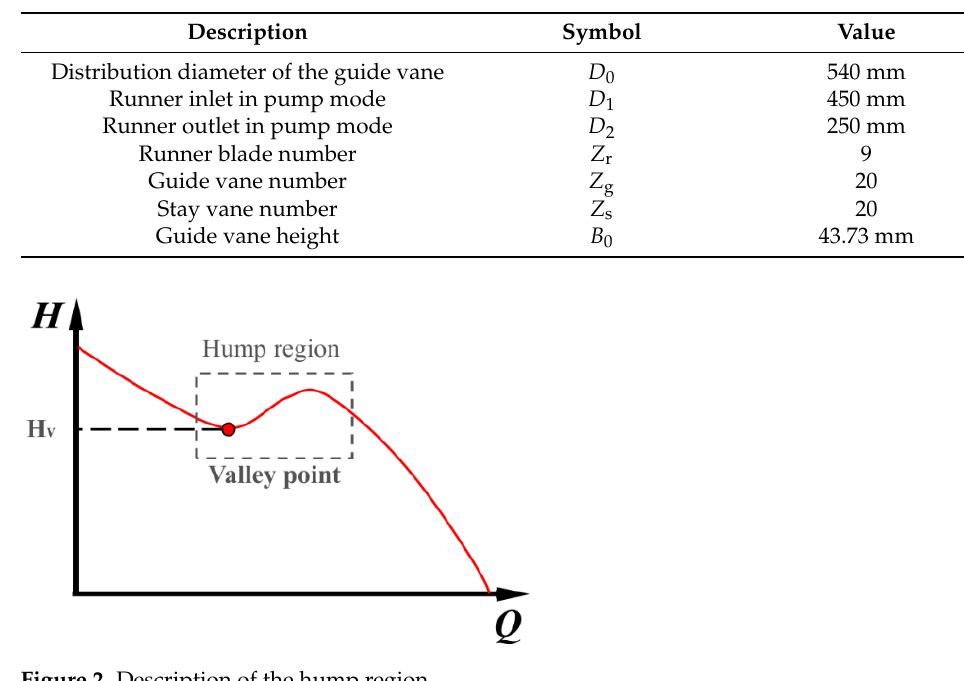
Figure 2. Description of the hump region. Table 1. Parameters of the pump turbine.